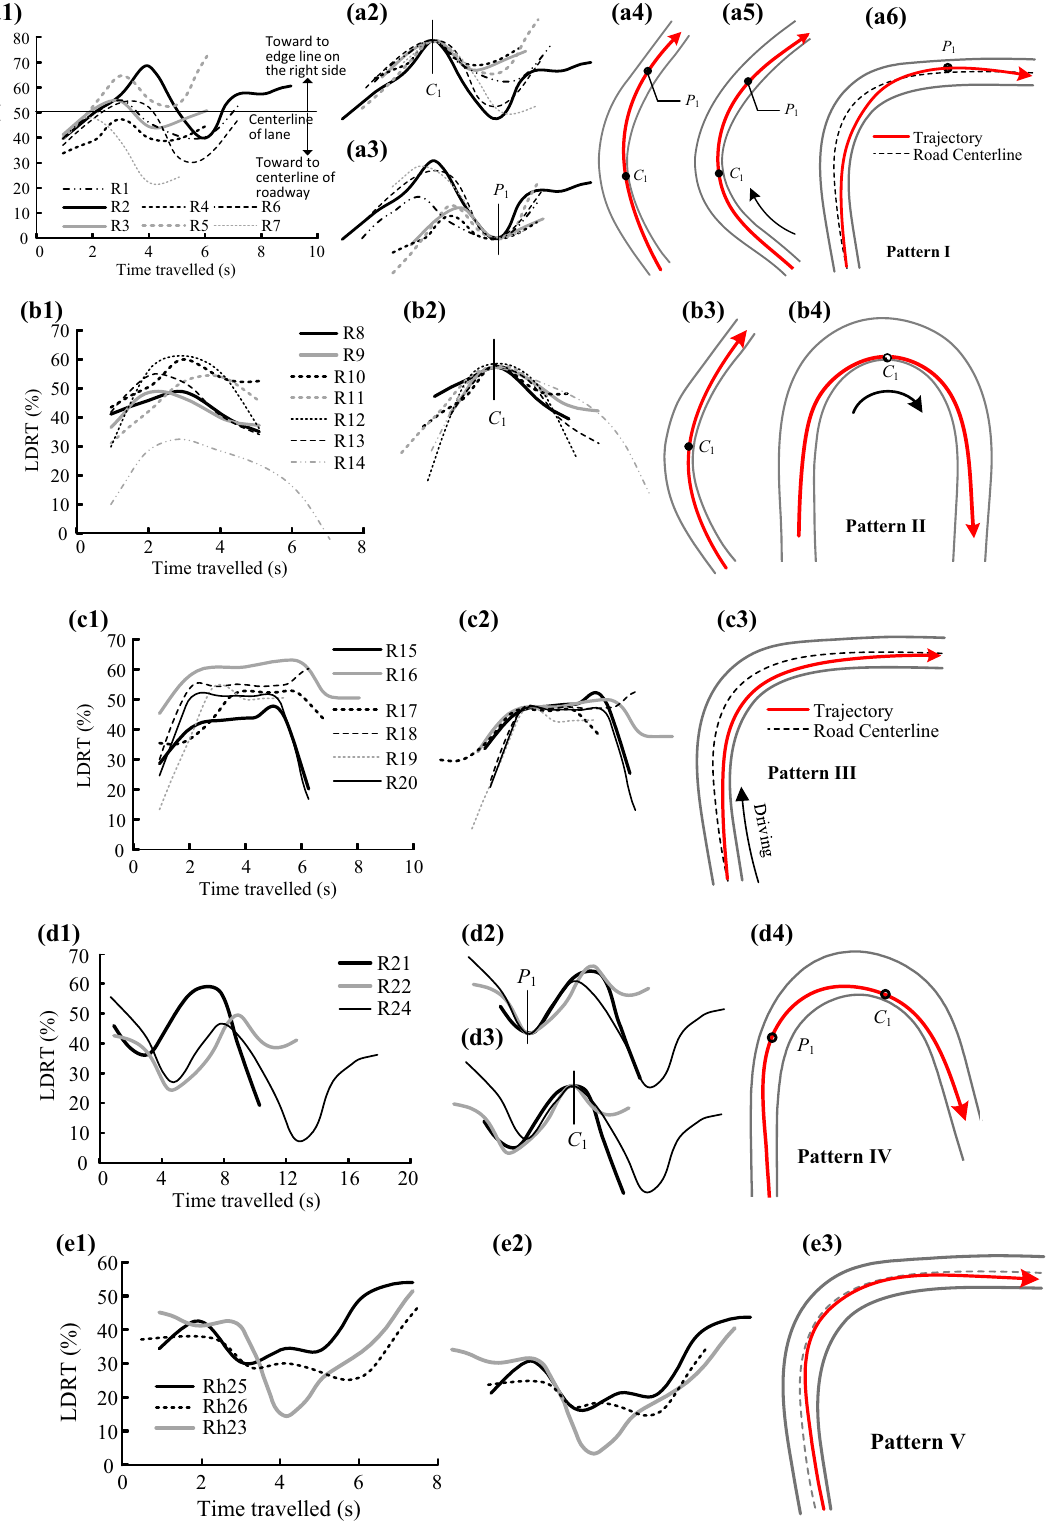
Fig. 7 Trajectory shape of four typical patterns and their corresponding LDRT profiles for right-hand bends: ( a1 – a5 ) Trajectory pattern I on right-hand bends; ( b1 – b4 ) Trajectory pattern II; ( c ) Trajectory pattern III; ( d ) Trajectory pattern IVand ( e ) Pattern